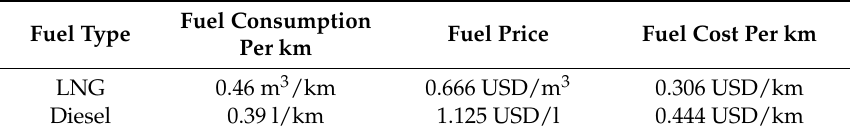
Table 1. Comparison of fuel costs per km for diesel and liquefied natural gas (LNG)